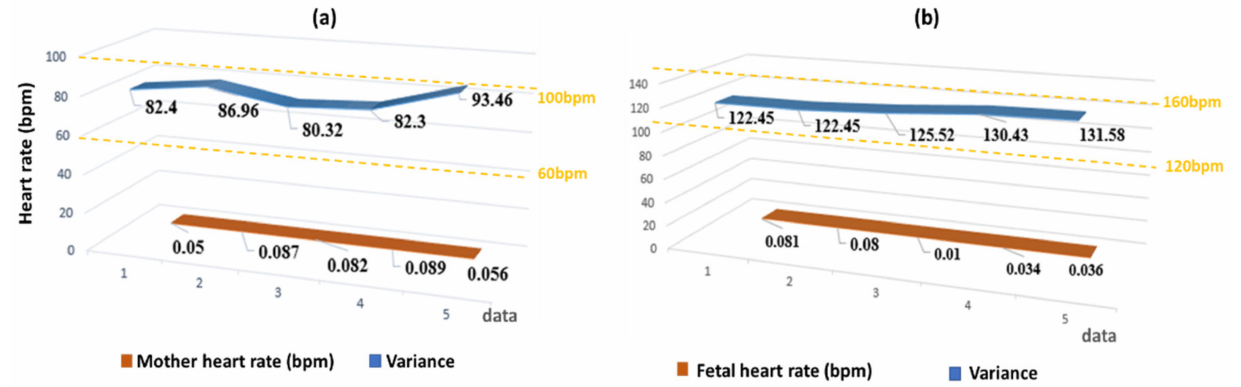
Figure 7. Evaluation of the accuracy of maternal and fetal heart rate calculations using variances. The blue curves in ( a ) and ( b ) were maternal and fetal heart rates calculated, respectively. The orange curves in ( a ) and ( b ) represented the difference between the heart rate and the real heart rate of each channel. The yellow dotted lines represented, respectively, the reference range of normal heart rates of the mother and the fetus.